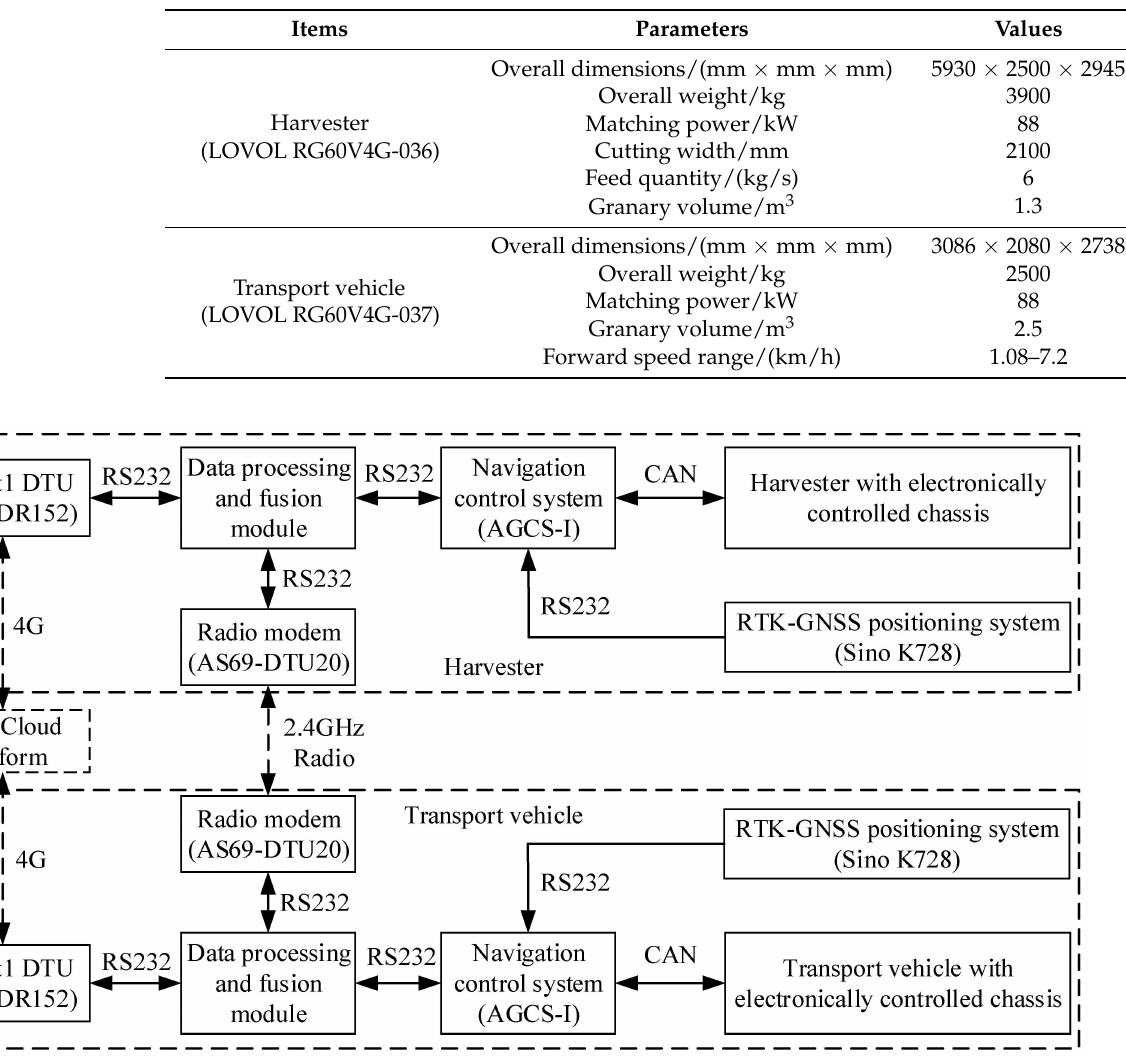
Figure 5. Structure diagram of collaborative harvest